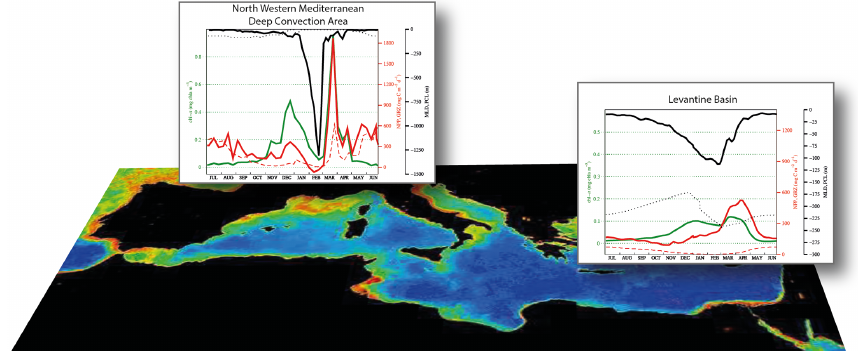
Fig. 10. Seasonal cycles of two contrasting ecosystem dynamics. The seasonal cycles of Chi-a concentration (green), MLD (black), net primary production (red solid), phosphocline (green dotted) and grazers (red dotted) are been modeled for the deep NWMed convection area (left) and for the Levantine Basin (right). The first reproduces very well the post-convection bloom (as seen in the Chi-a satellite images), while the latter follows a semi-tropical dynamics. Note that the vertical scales have been adjusted to accommodate the different intensities in the responses (after Lazzari et al., 2012,